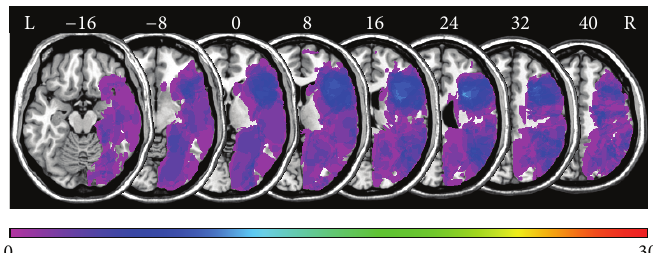
Figure 1: Overlay lesion plots of all thirty patients in MNI space. Eight axial slices. The number of overlapping lesions is illustrated by color, from violet ( 𝑁 = 1 ) to red ( 𝑁 = 30 ). Maximum overlap occurred in the right frontal lobe. The area colored light blue indicates overlapping lesions in eleven patients (37% lesion overlap). Numbers indicate MINI coordinates.